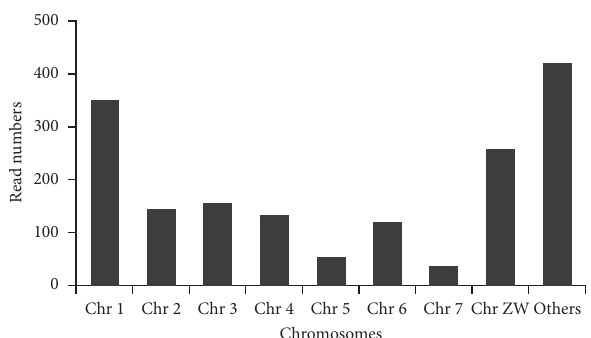
Figure 1: Location of the long noncoding RNA (lncRNA) tran- scripts and their read numbers in S. mansoni chromosomes. Others, lncRNAs that have not been mapped to any chromosomes.